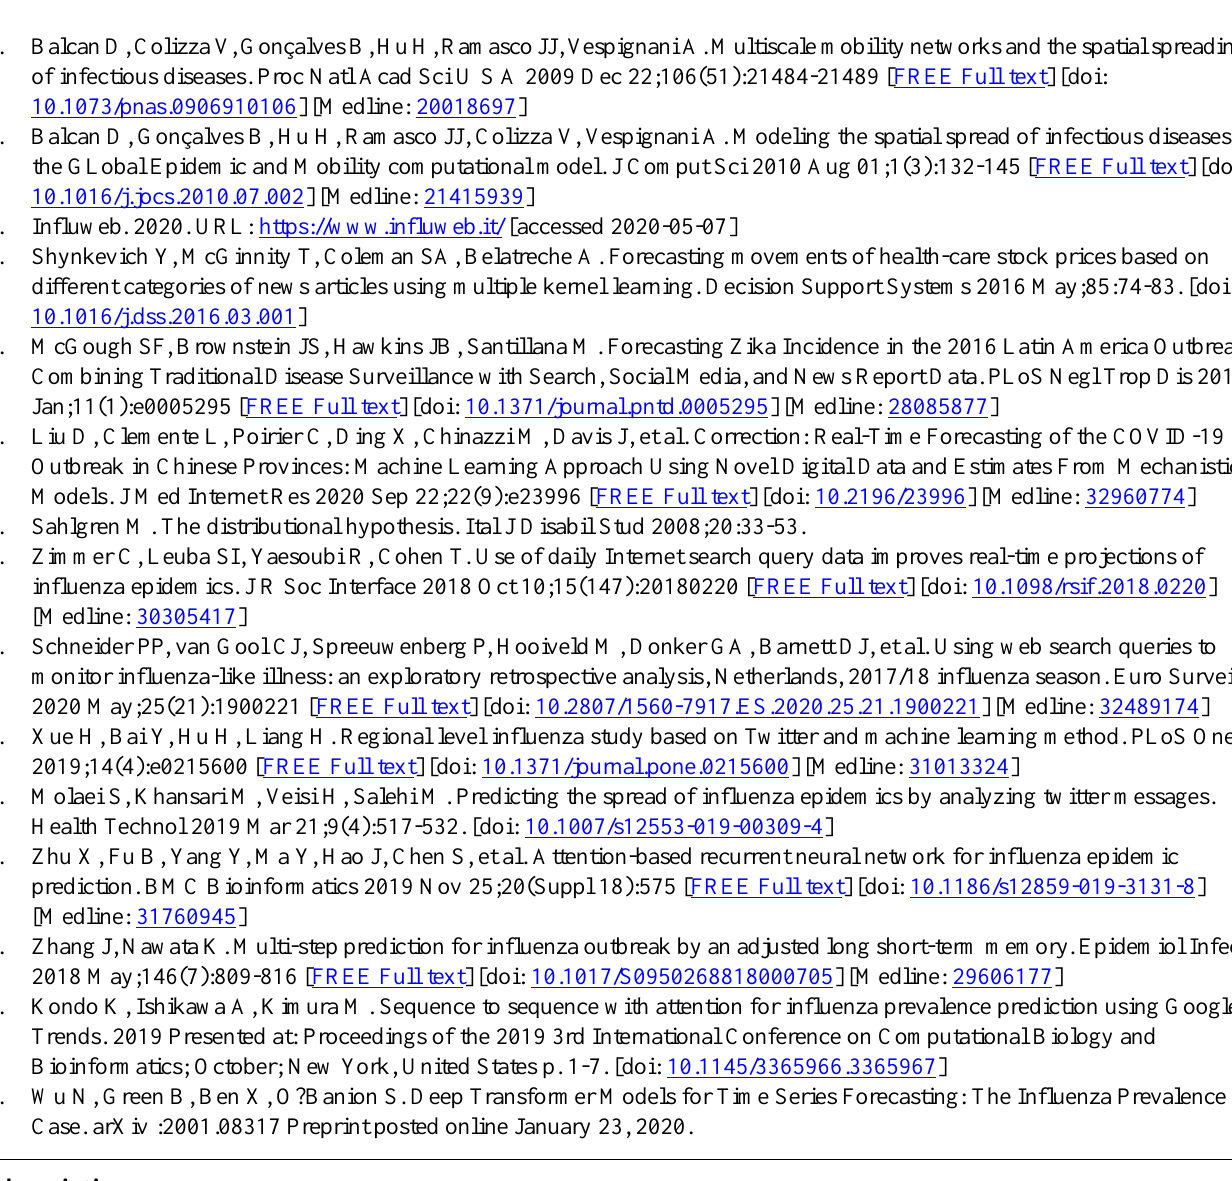
Abbreviations CBOW: continuous bag-of-words CDC: Centers for Disease Control and Prevention ILI: influenza-like illness LSTM: long short-term